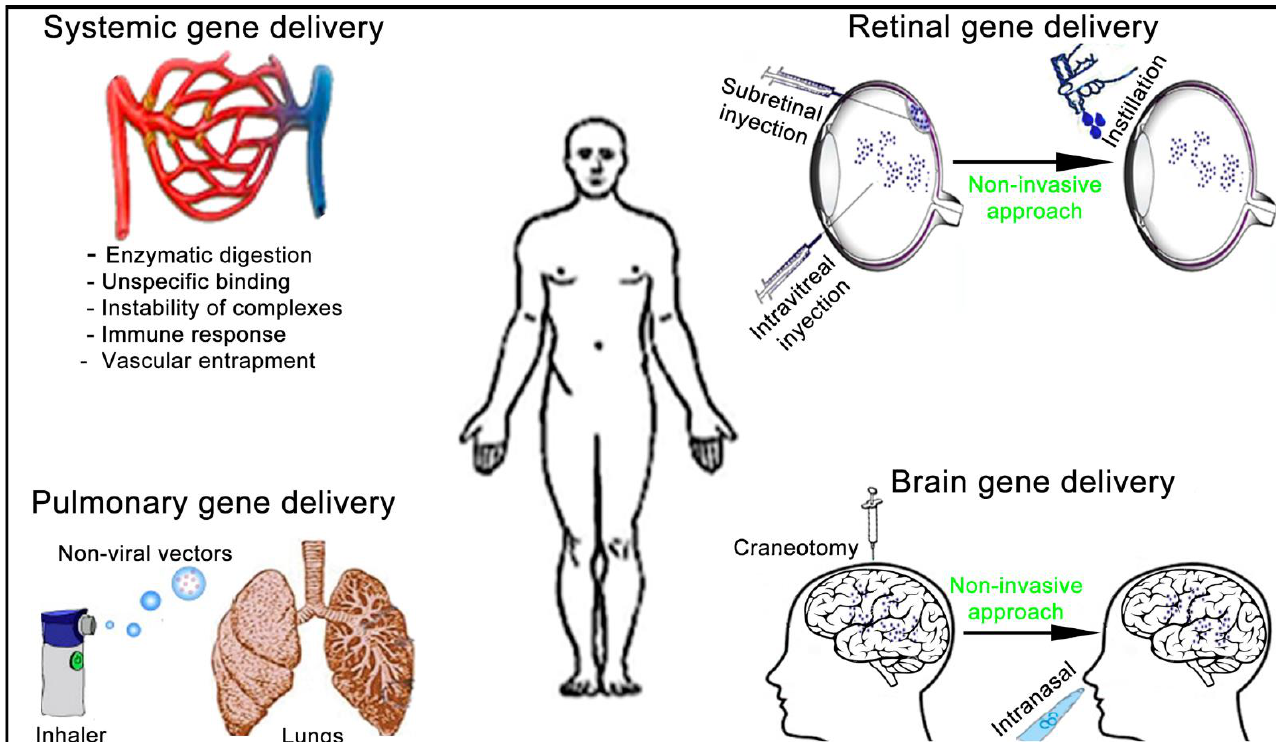
Figure 7. Schematic representation of the main administration routes to face systemic and tissue-specific human diseases by non-viral vectors gene therapy approach.